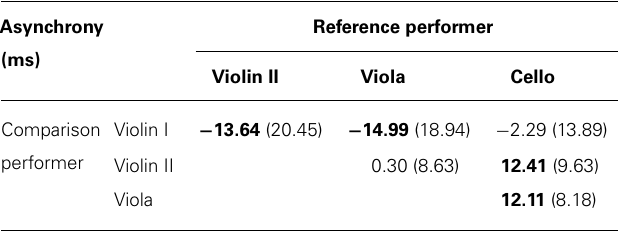
Table 1 | Mean asynchrony for each pair of